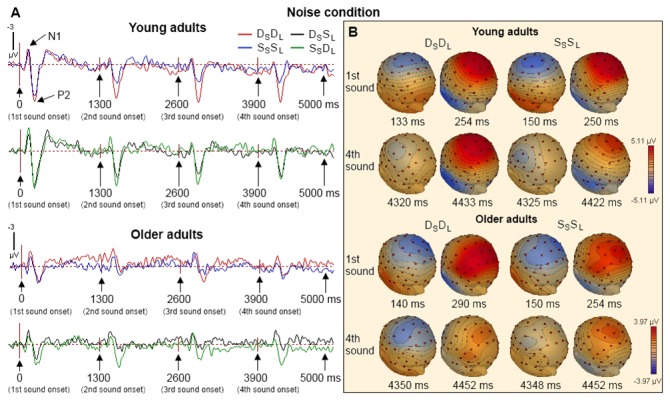

ERP waves elicited by four consecutive sound stimuli in the DSDL, DSSL, SSDL and SSSL trials in the noise condition. (A) Evoked responses averaged for young and older adults at Cz in the DSDL, DSSL, SSDL and SSSL trials. (B) The topographic maps of the N1 and P2 waves at latencies showing peak amplitudes at Cz for the 1st and 4th sound in the DSDL, and SSSL trials among young and older adults.